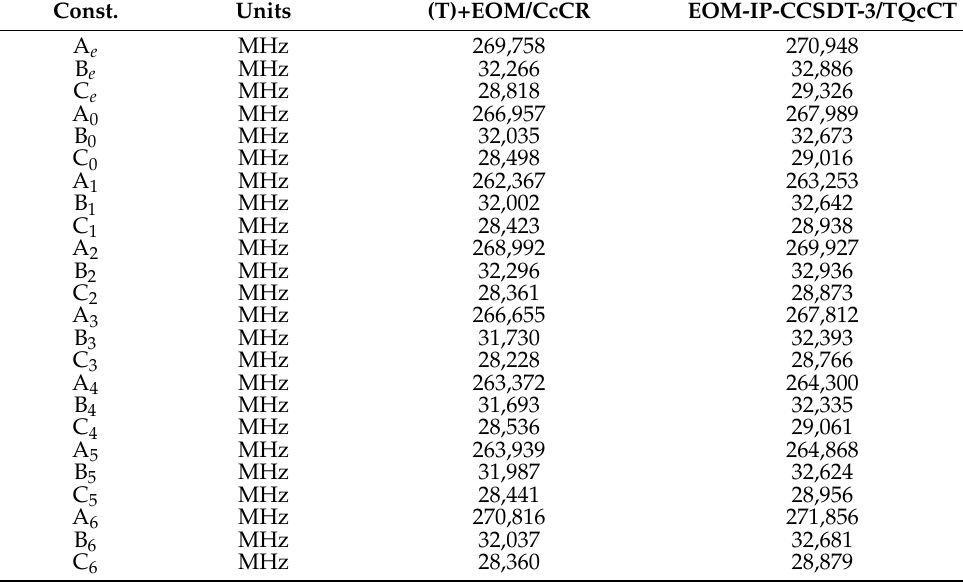
Table A7. Ã 2 B 2 H 2 CO + Rotational Constants